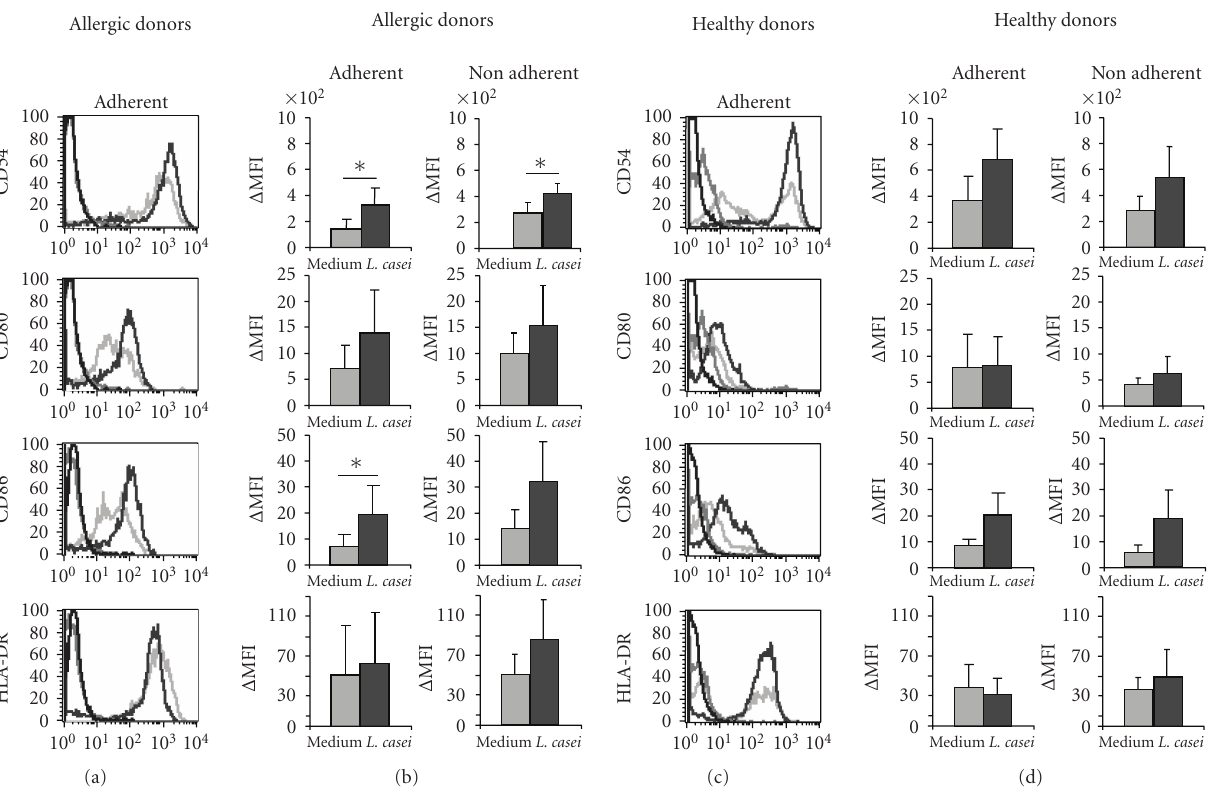
Figure 3: E ff ect of L. casei stimulation on DC phenotype . Monocyte-derived dendritic cells from house dust mite sensitive-patients (a) and (b) and from healthy donors (c) and (d) were exposed (dark grey line) or not (grey line) to L. casei for 48hours in the Transwell model. (a) and (c) Adherent DC were analyzed by flow cytometry for CD80, CD86, HLA-DR, and CD54 expression. the black line represents the reactivity of fluorochrome-matched isotype control mAbs. One representative experiment (out of 6 and 7, for allergic and healthy donors, resp.) is shown. (b), (d) The mean fluorescence intensity ( Δ MFI) of the expression of each marker by adherent and nonadherent DC after stimulation with medium, and L.casei is represented for both allergic ((b), n = 6) and healthy donors ((d), n = 7). ∗ P < . 05.